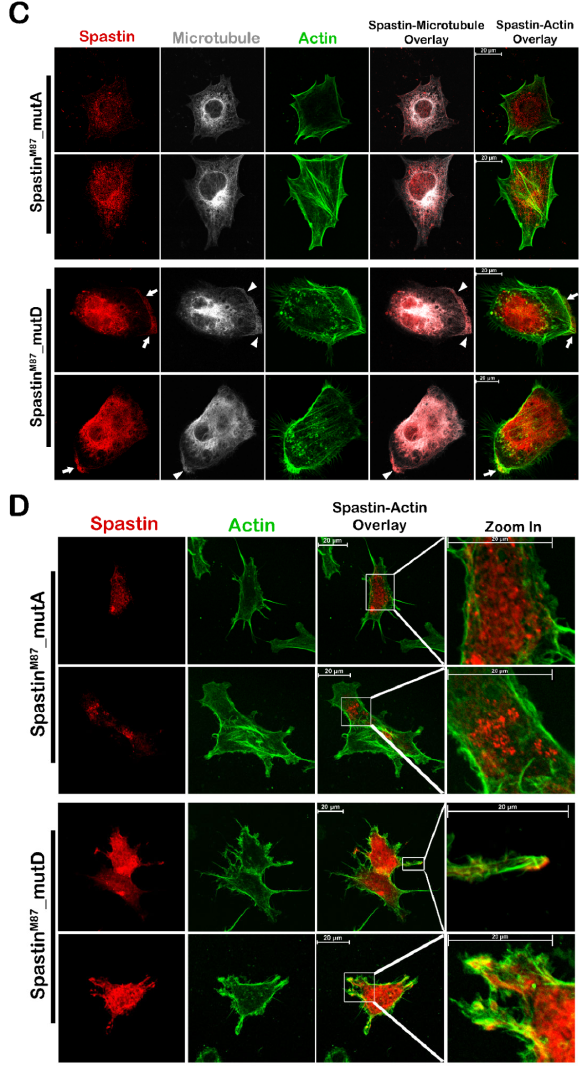
Figure 6. M87-Spastin is directed to actin filaments through phosphorylation of the microtubule- binding domain (MBD). ( A ) The expression levels and molecular weights of the proteins expressed from Spastin M87 , or Spastin M1&M87 vectors were analyzed through Western blot (WB). T98G cells were transfected with either mock, Spastin M87 , or Spastin M1&M87 vectors, and then endogenous or overexpressed Spastin expressions were detected by WB using a Spastin-specific antibody. β -actin was used as the loading control. ( B ) Immunocytochemistry (ICC) analysis was used to examine the impact of EGF treatment on the localization of wild-type M87-Spastin. T98G cells were transfected with Spastin M87 vector for 24 h with or without EGF treatment. Then, cells were fixed with PFA and stained with Myc-tag antibody for Spastin (red), phallacidin for actin filaments (green), and tubulin antibody for microtubule (gray). ( C , D ) ICC was used to detect the localization of mutant M87 proteins relative to both microtubules and actins ( C ) or relative to actin filaments with only higher magnification ( D ). T98G cells were transfected with either Spastin M87 _mutA or Spastin M87 _mutD vectors for 24 h. Then, cells were fixed with PFA and stained with Myc-tag antibody for Spastin (red), phallacidin for actin filaments (green), and tubulin antibody for microtubule (gray). Arrows indicate color transformation caused by the co-localization of Spastin with actin filaments (in B , C ; lane of Spastin actin overlay), while arrowheads indicate microtubule structure that enriched with Spastin and actin filaments (in C ; lane of